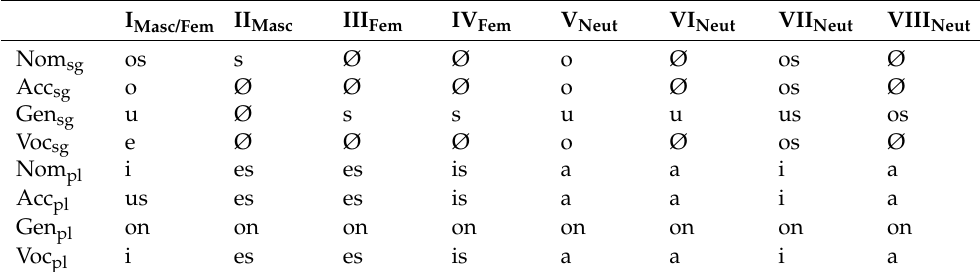
Table 3. Standard Modern Greek (SMG) Declension